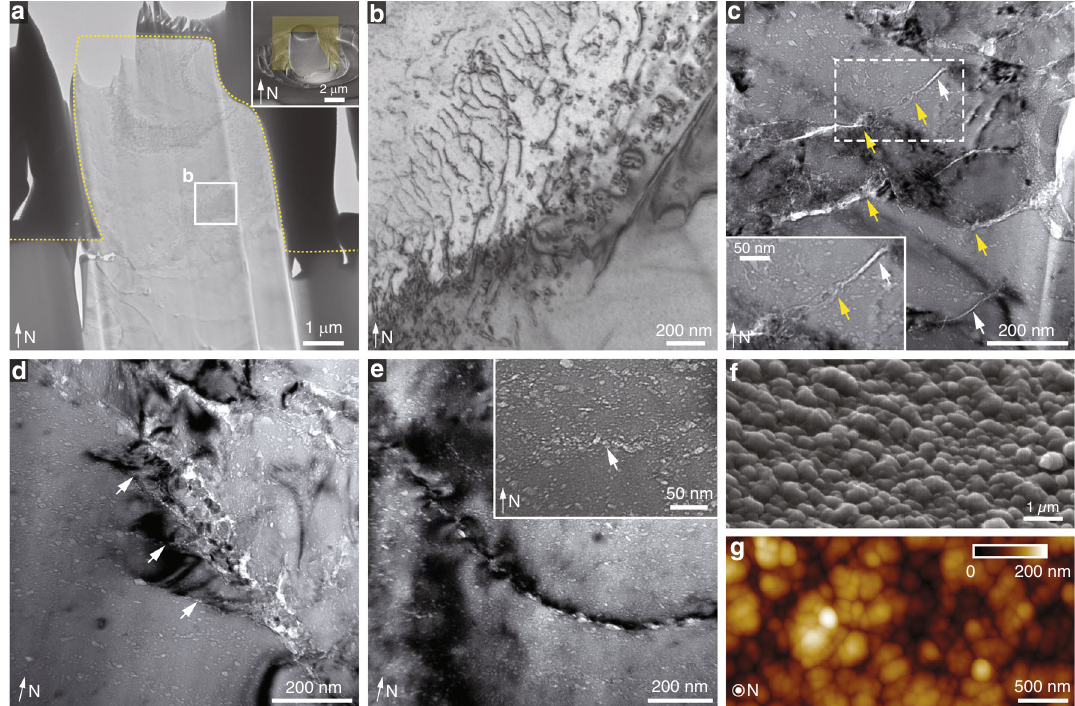
Fig. 5 Microscale deformation mechanisms in biogenic and geological calcite. a TEM image of a thin slice taken from a signi fi cantly deformed geological calcite micro-pillar after compression testing. Inset, SEM image of the micro-pillar used for TEM sample preparation and the yellow plane shows the orientation of the TEM slice. b High magni fi cation TEM image showing the dislocation arrays developed within the deformed geological calcite micro-pillar. c TEM image showing micro-/nano-scale cracks developed within the A. rigida biogenic calcite after deformation. White and yellow arrows indicate the cracks in the low- and high-density defect regions, respectively. d TEM image taken at the boundary of a fractured zone in biogenic calcite, showing the propagation directions of several cracks (white arrows) in parallel to the long axes of the defects, which is perpendicular to the calcite ’ s c -axis. e TEM image demonstrating that a crack formed via the coalescence of micro-cracks initiated from defects and followed the long-axis directions of defects. Inset: TEM imaging showing a site of crack initiation through nanoscopic damage coalescence from adjacent defects. f SEM and g atomic force micrograph (AFM) of the fractured surface of biogenic calcite, showing the nanoscale rough